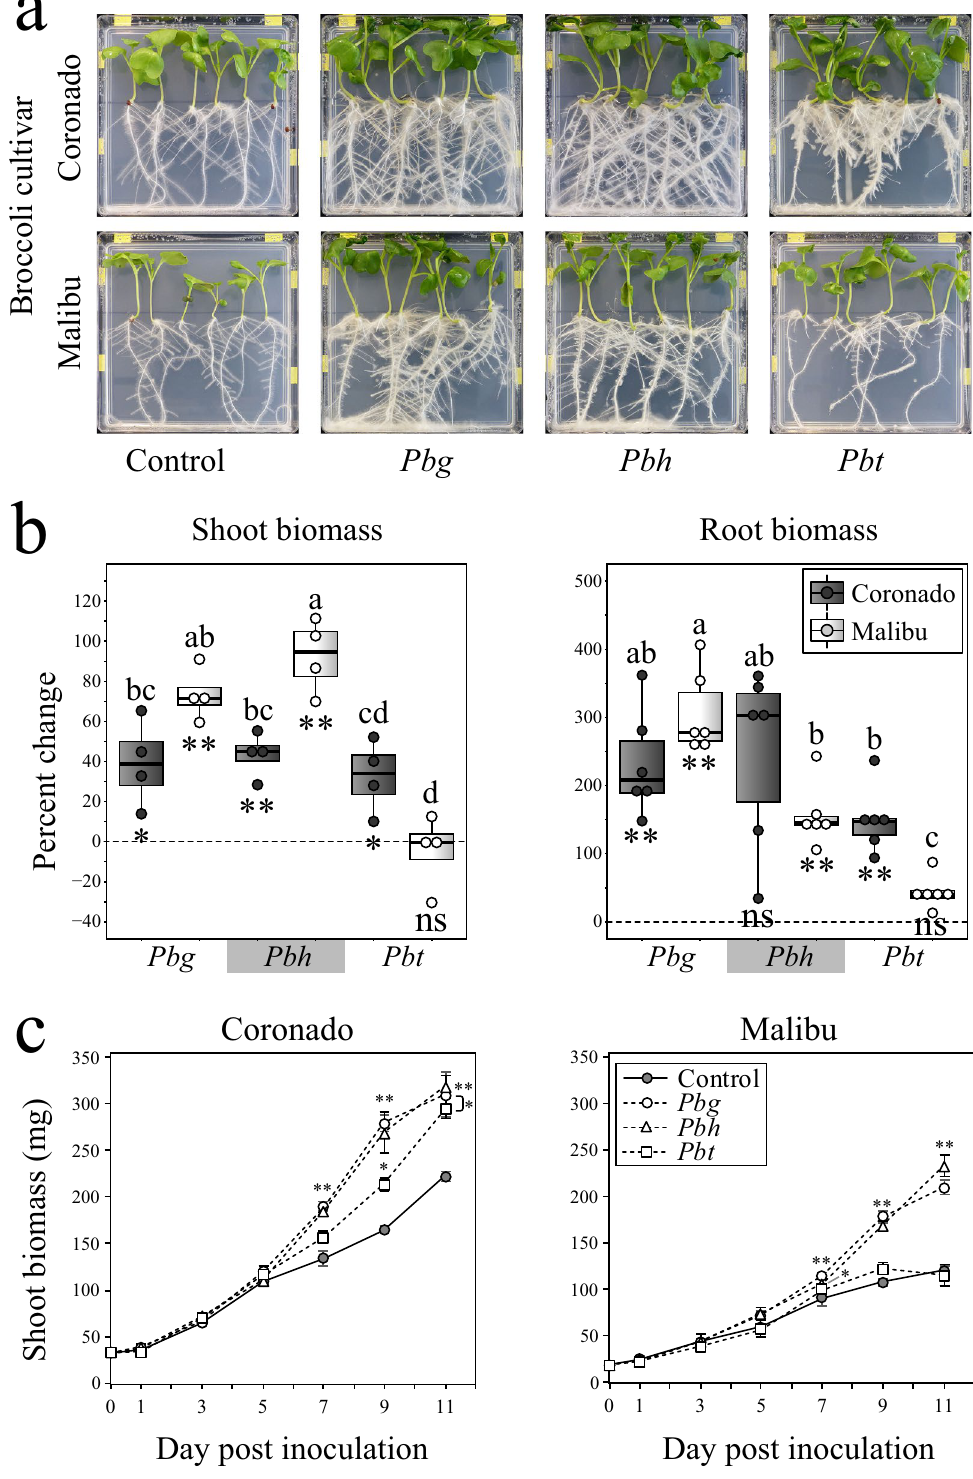
Figure 1. Biomass and phenotypic changes in Broccoli cultivars in response to root tip inoculation with strains of three Paraburkholderia species. ( a ) Pictures of MS agar plate with two Broccoli cultivars (Coronado and Malibu) at 11 days post inoculation with strains of three Paraburkholderia species ( Pbg : Paraburkholderia graminis PHS1, Pbh : P. hospita mHSR1, and Pbt : P. terricola mHS1). ( b ) Percent changes in shoot and root biomass (mean ± standard error, n = 4 (shoot) and n = 6 (root)) of two Broccoli cultivars inoculated with the strains of the Paraburkholderia species. Treatments sharing the same letters are not significantly different (Two-way ANOVA, Tukey’s HSD post hoc test, P < 0.05). ( c ) Temporal changes in shoot biomass of two Broccoli cultivars (Coronado and Malibu) inoculated with the Paraburkholderia species. Asterisks in panels b and c denote significant differences from the non-treated control samples (two-tailed Student’s t test: * P < 0.05; ** P <